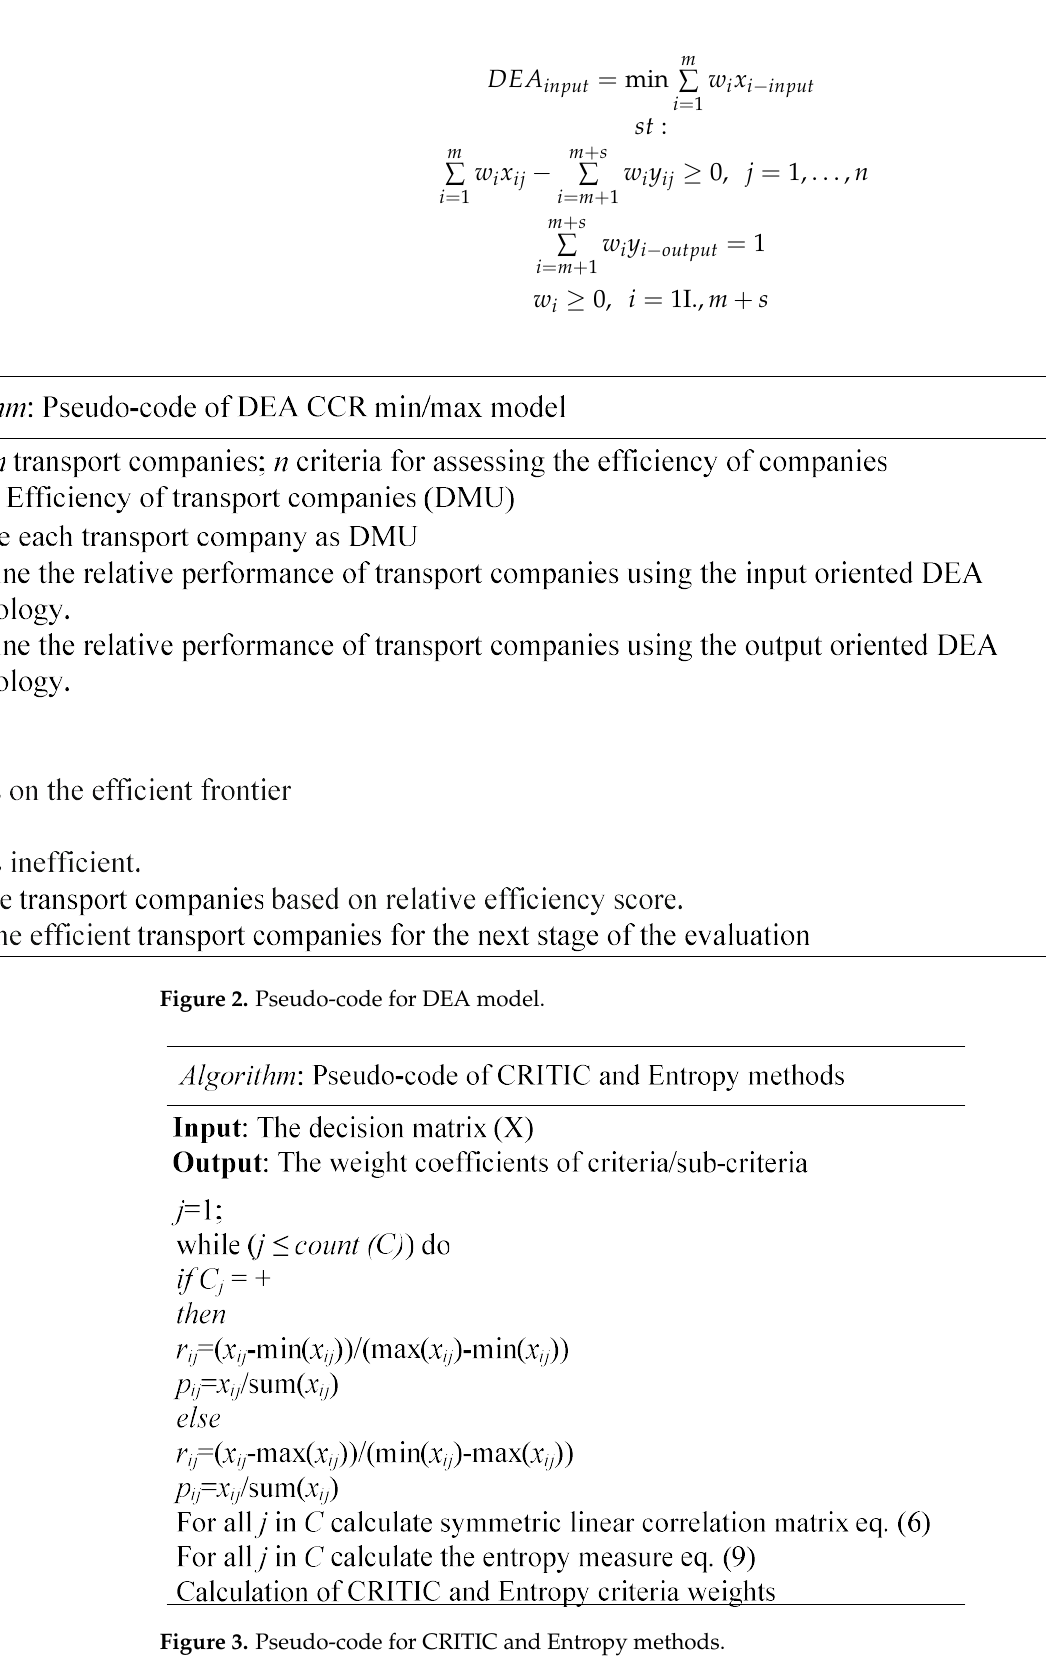
Figure 3. Pseudo-code for CRITIC and Entropy methods.